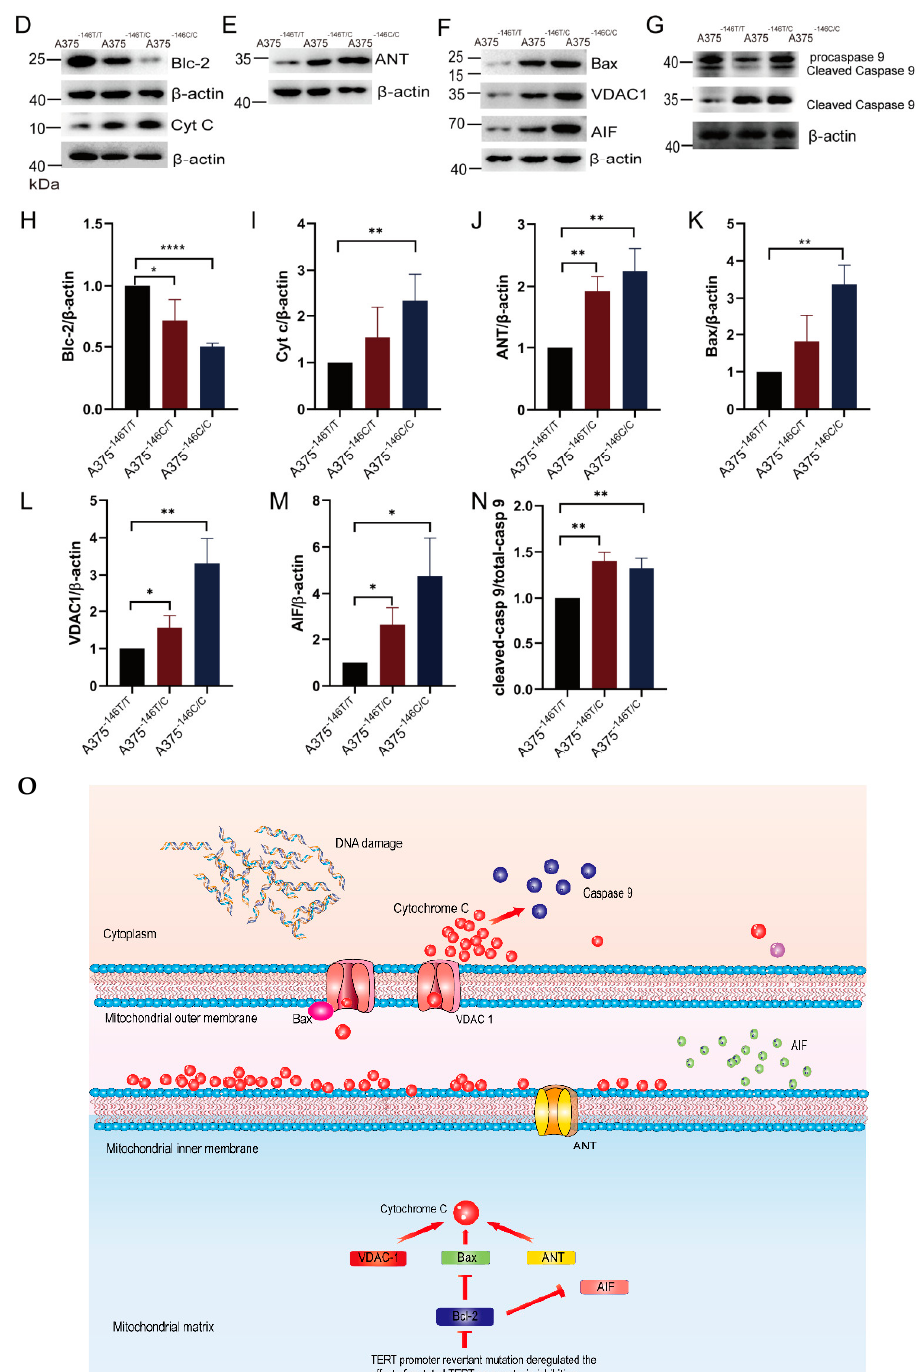
Figure 6. Abrogation of the inhibitory effect of mutant TERT on apoptosis. ( A – C ) FACs analysis with Annexin V-FITC/PI; ( A , C ) the early apoptosis detection; ( B , C ) the late stage apoptosis detec- tion; ( D , H , I ) Western blot and gray value analysis of Bcl-2 and Cyt c protein expression in A375 - 146T/T , A375 -146T/C , and A375 -146C/C ; ( E , J ) Western blot and gray value analysis of ANT expression in A375 -146T/T , A375 -146T/C , and A375 -146C/C ; ( F , K – M ) Western blot analysis of Bax, VDAC1, and AIF ex- pression in A375 -146T/T , A375 -146T/C , and A375 -146C/C ; ( G , N ) Western blot analysis of caspase 9 expres- sion in A375 -146T/T , A375 -146T/C , and A375 -146C/C ; ( O ) schematic diagram of intrinsic apoptosis induced by TERT revertant mutation. AIF: apoptosis-inducing factor; VDAC1: voltage-dependent anion channel 1; ANT: adenine nucleotide translocator; Bax: Bcl-2-associated X protein. * p < 0.05, ** p < 0.01, *** p < 0.001, **** p < 0.0001, t -test. The authors apologize for any inconvenience caused and state that the scientific con- clusions are unaffected. This correction was approved by the Academic Editor. The origi- nal publication has also been updated.